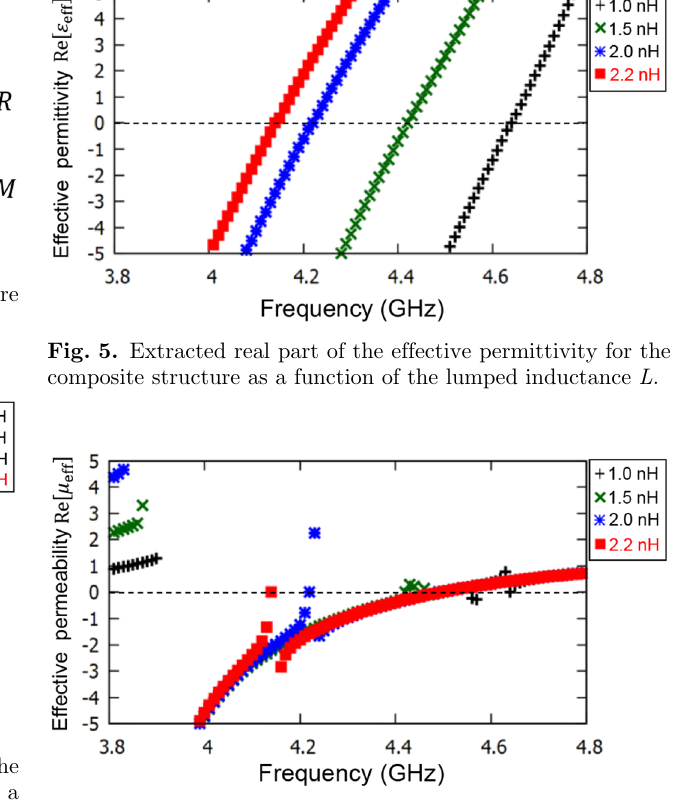
Fig. 6. Extracted real part of the effective permeability for the structures as a function of inserted inductance L